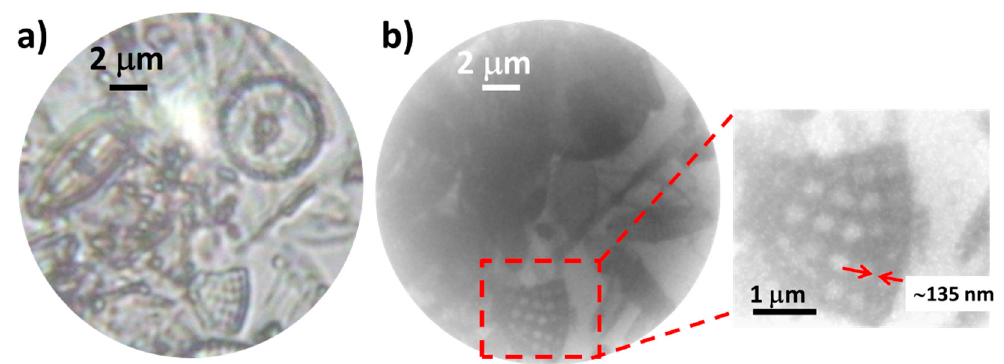
Figure 14. Images of diatoms acquired ( a ) with the optical microscope and ( b ) with the EUV microscope. The zoomed inset in ( b ) shows small features, of the order of 135 nm.